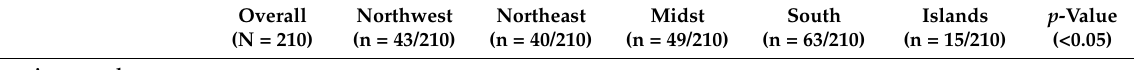
Table 4. Competence area in wound care: anatomy and physiology area. Each query expects a score value as an answer, based on a seven-point scale (Likert scale) ranging from 1 (strongly disagree) to 7 (strongly agree). Results are shown as mean ± standard deviation (mean ±